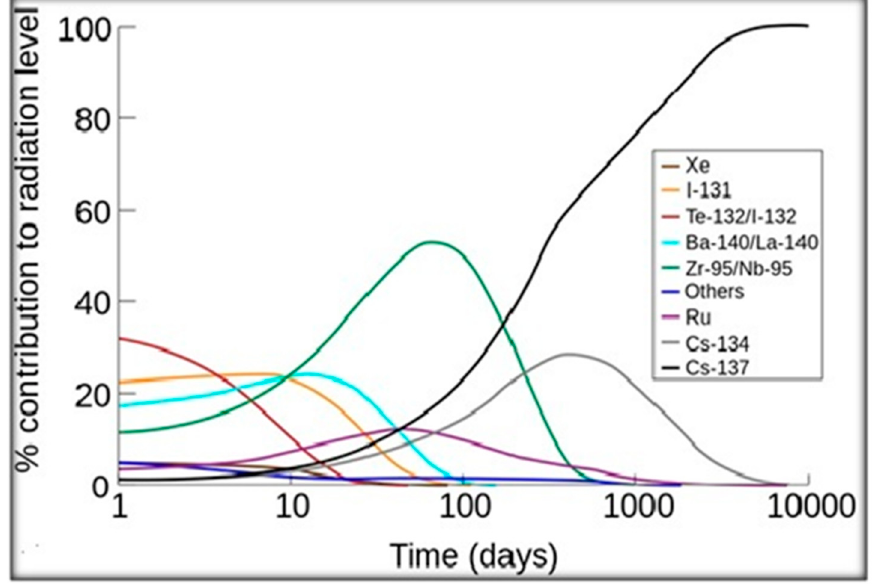
Figure 2. The relative contributions of the major nuclides to the radioactive contamination of the air after an accident. Retrieved on 2009 from [12]